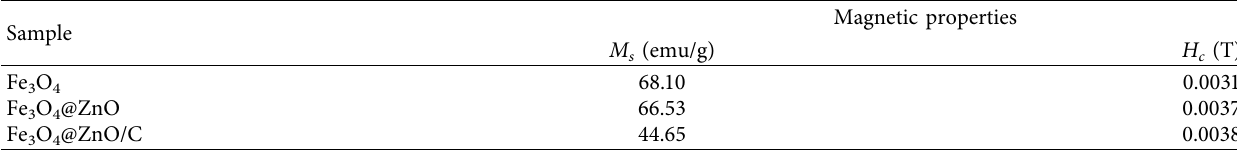
Table 1: Magnetic properties of Fe